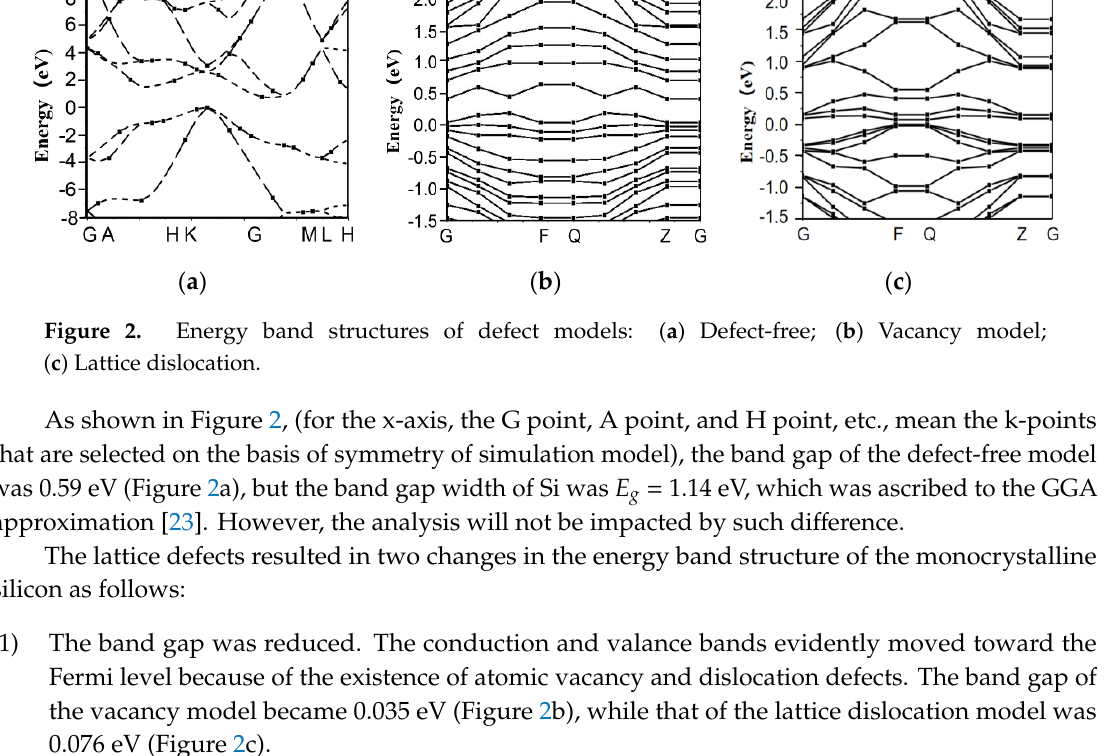
Figure 1. Structural models of ( a ) Defect-free; ( b ) Vacancy; ( c ) Lattice dislocation.